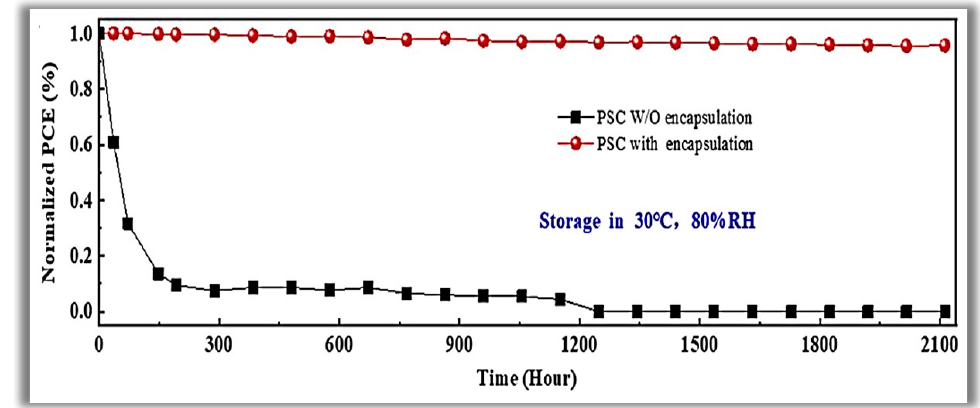
Figure 8. Time evolution of power conversion efficiency for the perovskite solar cells with and without encapsulation under high humidity. Reprinted with permission from Ref. [77]. Copyright 2020, Elsevier.